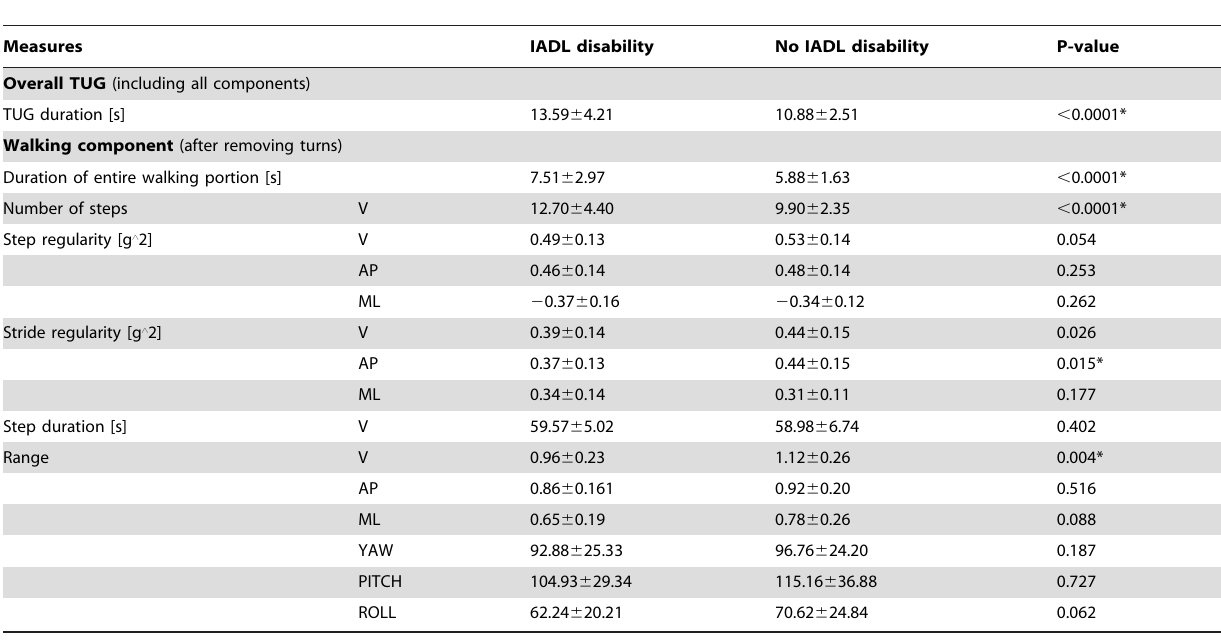
Table 2. TUG signal derived measures of walking in subjects with and without IADL disability.